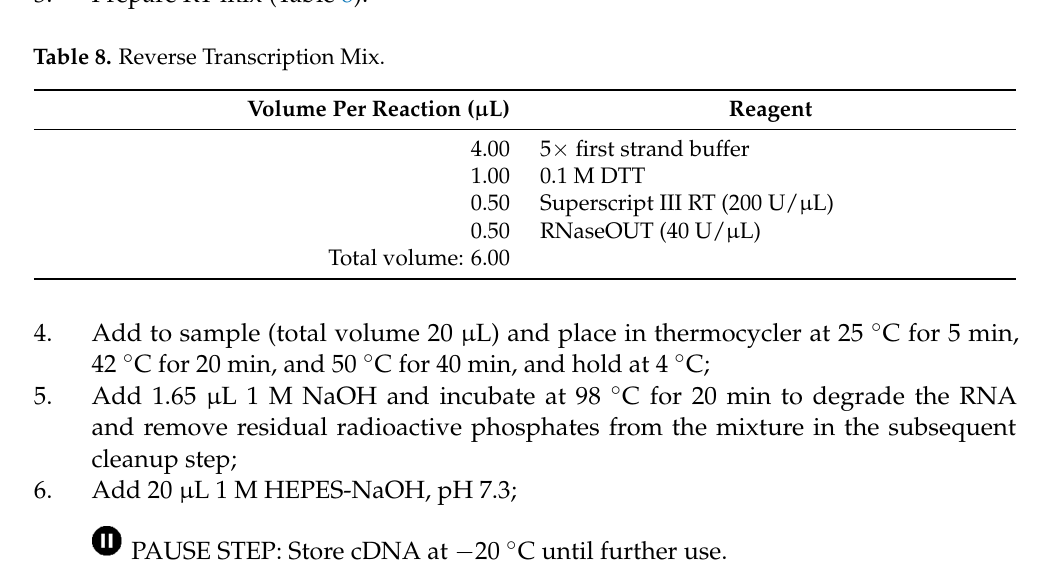
Table 8. Reverse Transcription